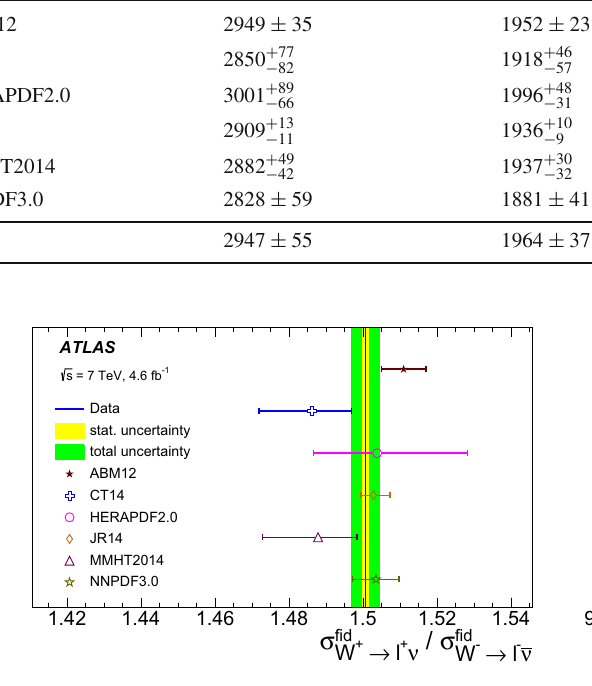
Fig. 20 Ratios of the fiducial cross sections times leptonic branch- based on various PDF sets are shown with open symbols of different /σ fid /σ fid colours . The uncertainties of the theoretical calculations correspond to ing ratios of σ fid ( left ) and σ fid W + → (cid:3) + ν W − → (cid:3) − ¯ ν W ± → (cid:3) ± ν Z /γ ∗ → (cid:3) + (cid:3) − the PDF uncertainties ( right ). The data ( solid blue line ) are shown with the statistical ( yellow band ) and the total uncertainties ( green band ). Theoretical predictions